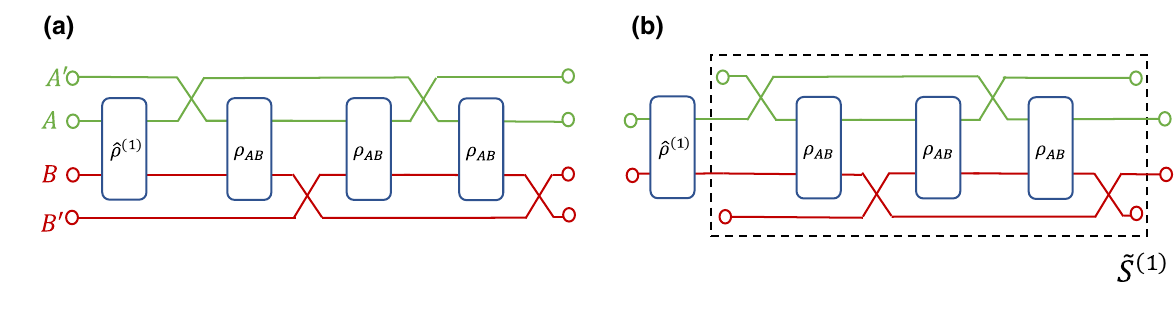
(cid:19) (cid:10)(cid:20) (cid:9) S ˆ ρ ( 1 ) ⊗ ρ ⊗ ( 3 ) , from which it is AB ˜ S ( 1 ) in Eq. (C49) (marked